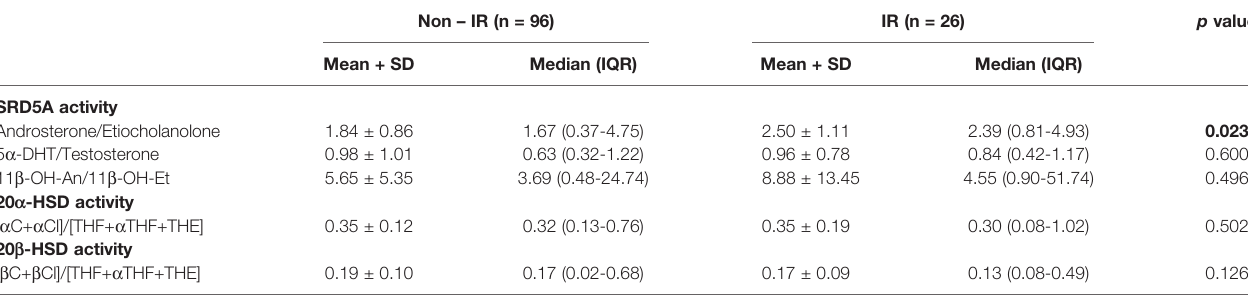
TABLE 3 | Ratios of steroid metabolites (indicative of enzyme activity): comparison between obese children and adolescents with and without insulin resistance